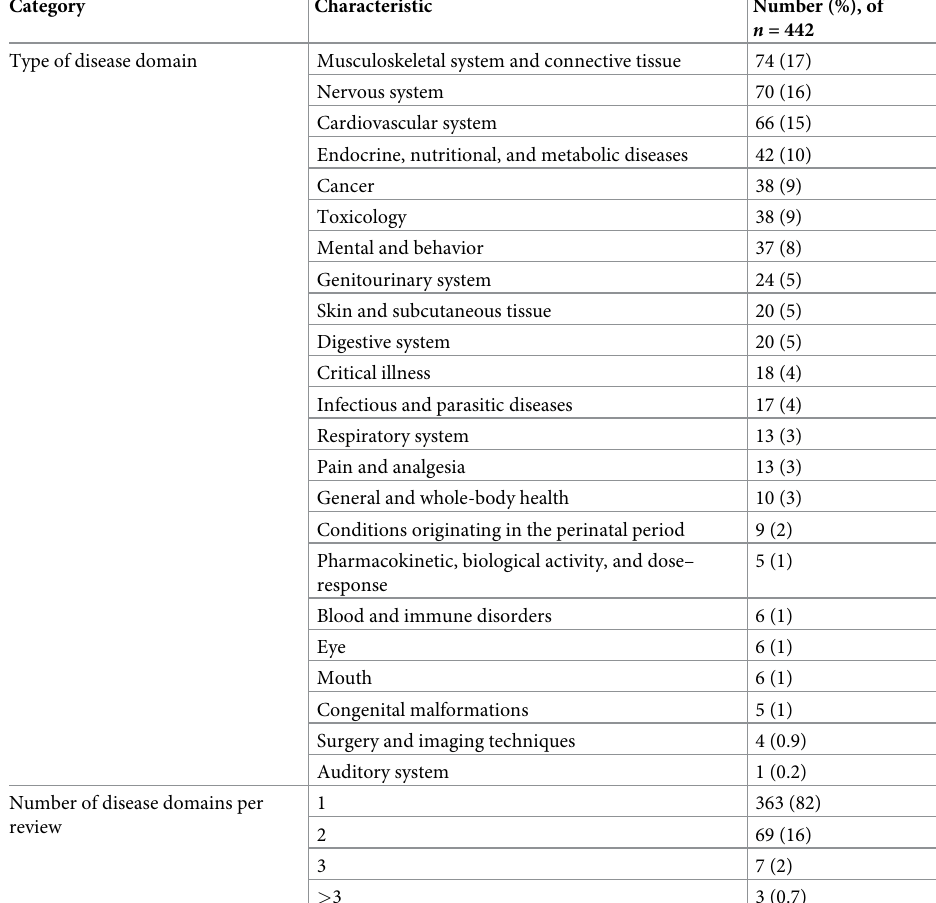
Table 2. Disease domains investigated in the preclinical systematic reviews.